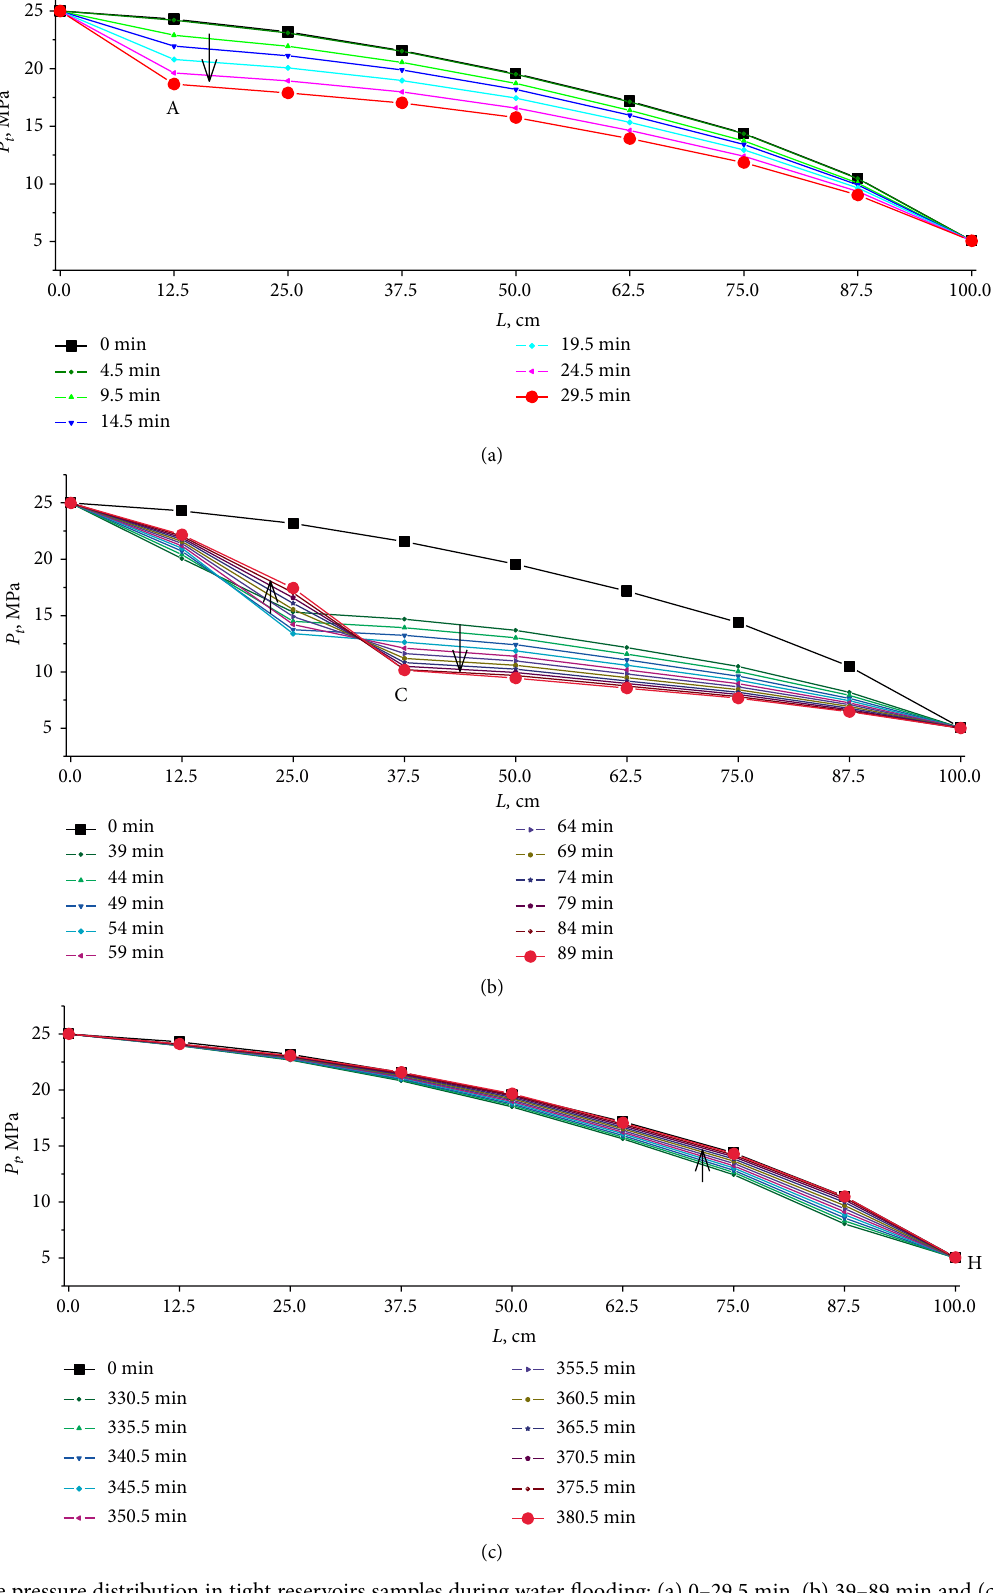
Figure 12: The pressure distribution in tight reservoirs samples during water flooding: (a) 0–29.5 min, (b) 39–89 min and (c) 330.5–380.5 min. The black curve of 0 min represents the pressure characteristics of oil